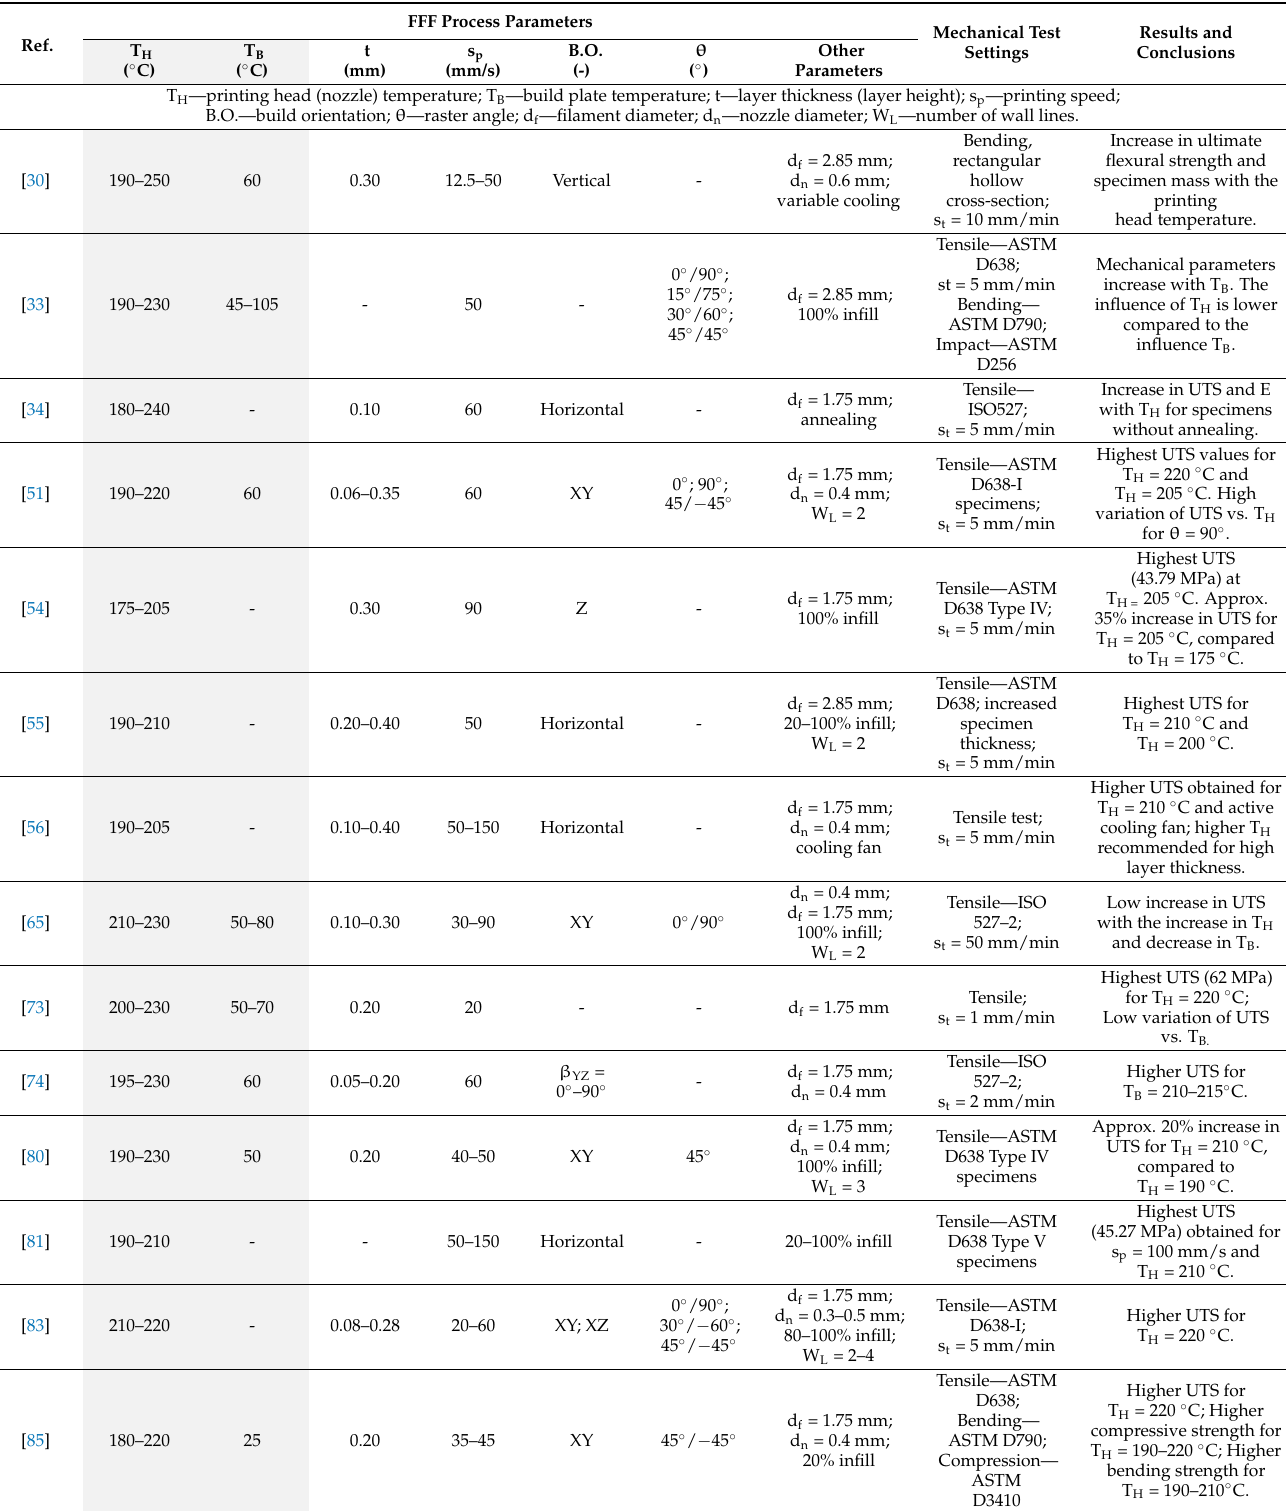
Table 4. The influence of the head temperature and build plate temperature on the mechanical properties of FFF-printed